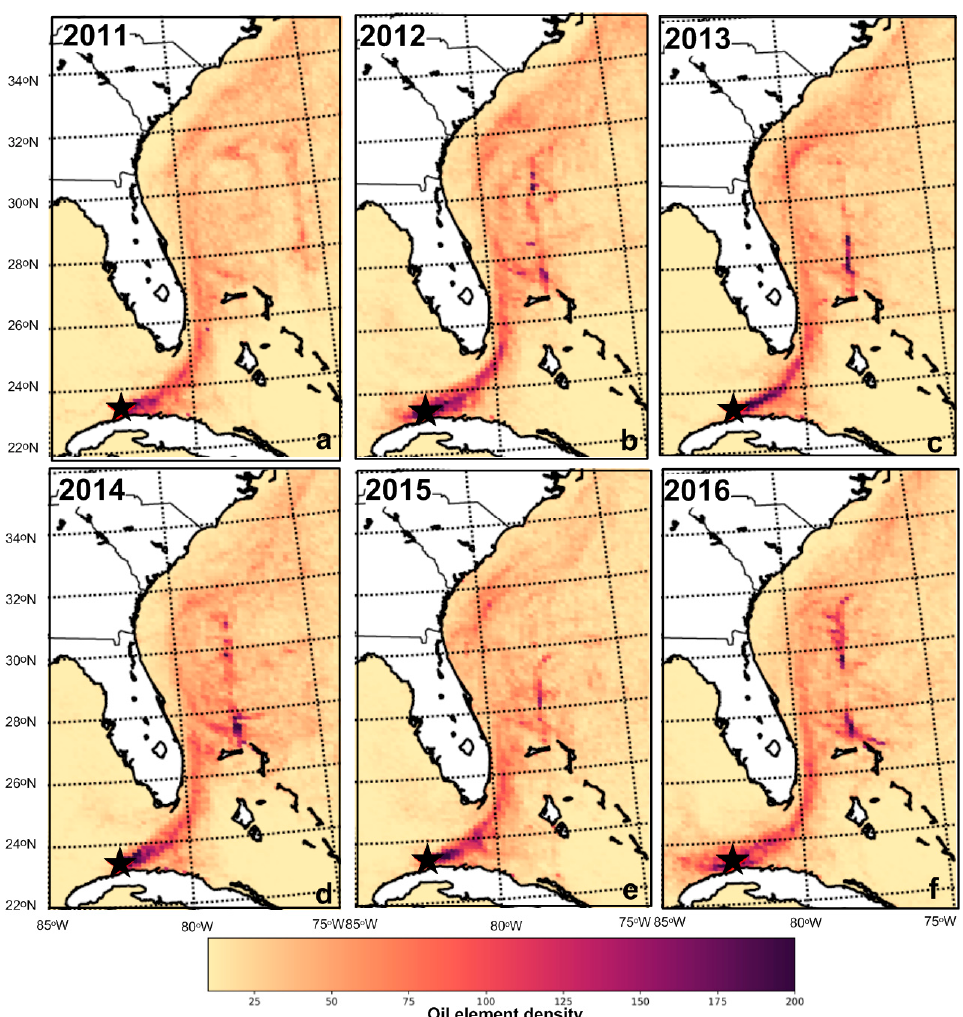
Figure 7. Same as Figure 5 but for Point 8 for ( a ) 2011, ( b ) 2012, ( c ) 2013, ( d ) 2014, ( e ) 2015, and ( f ) 2016 .